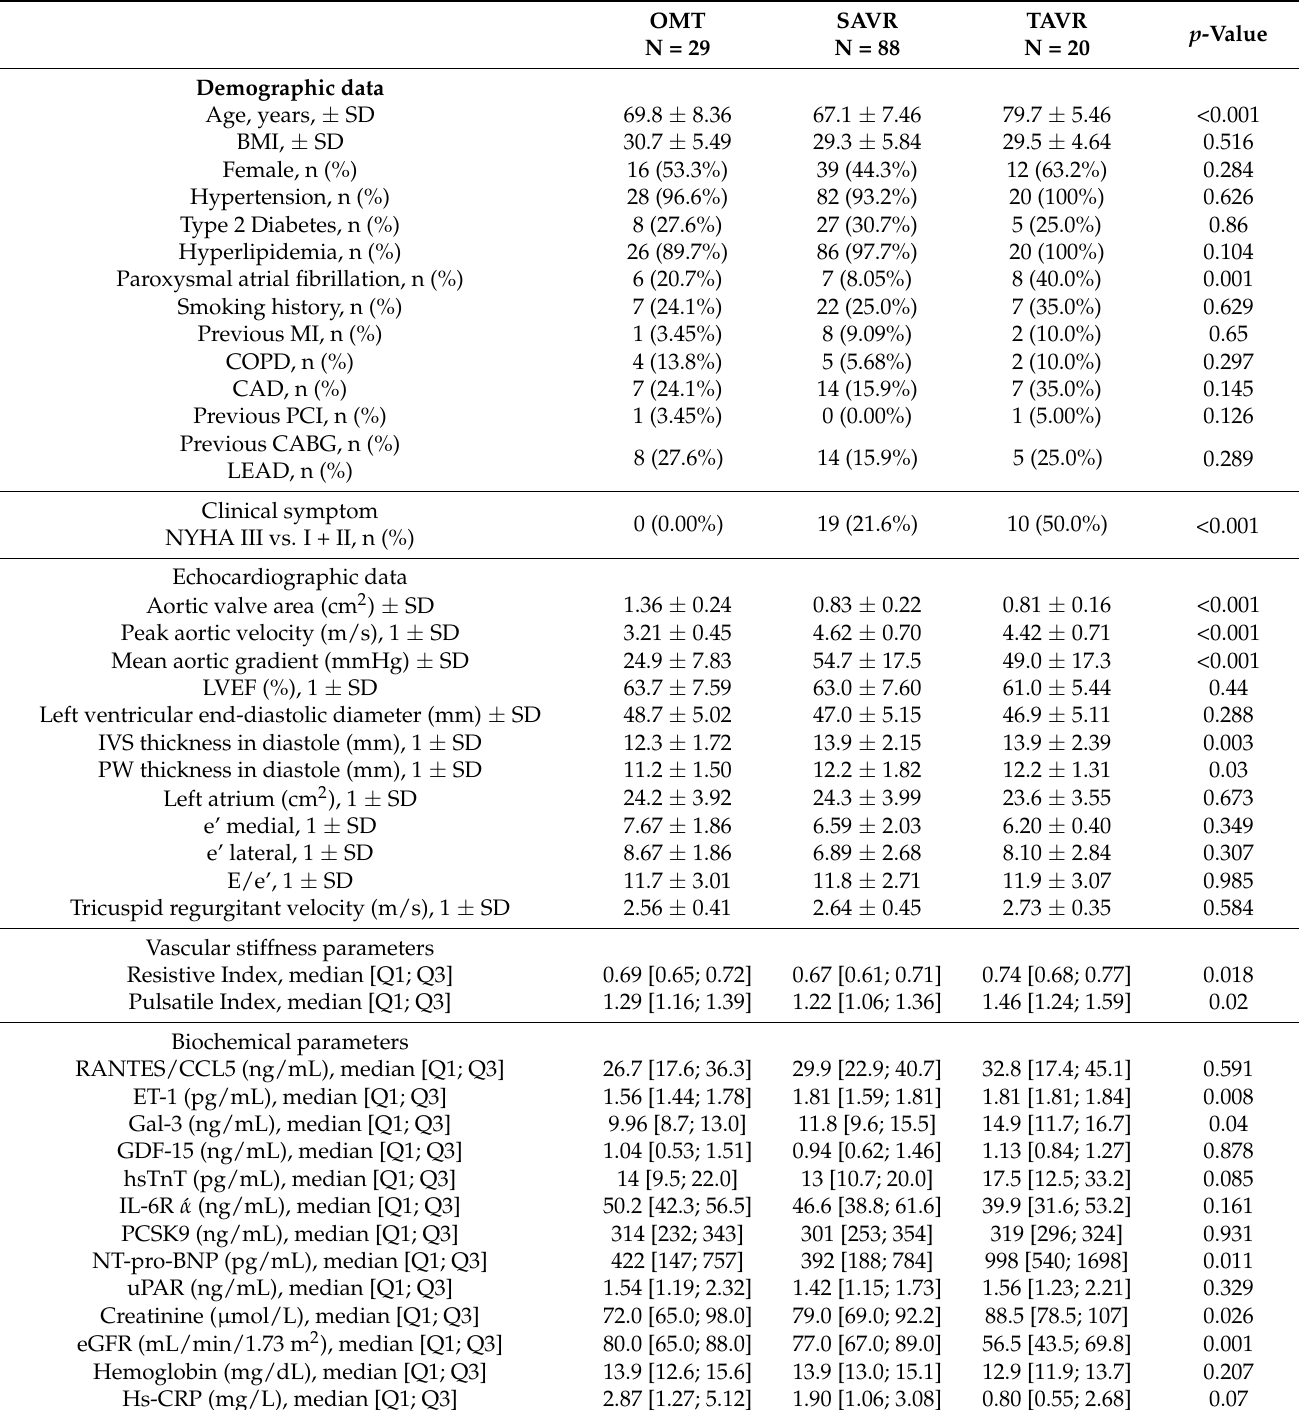
Table 3. Detailed comparison of patients according to final referral to observational group (OMT), SAVR, and